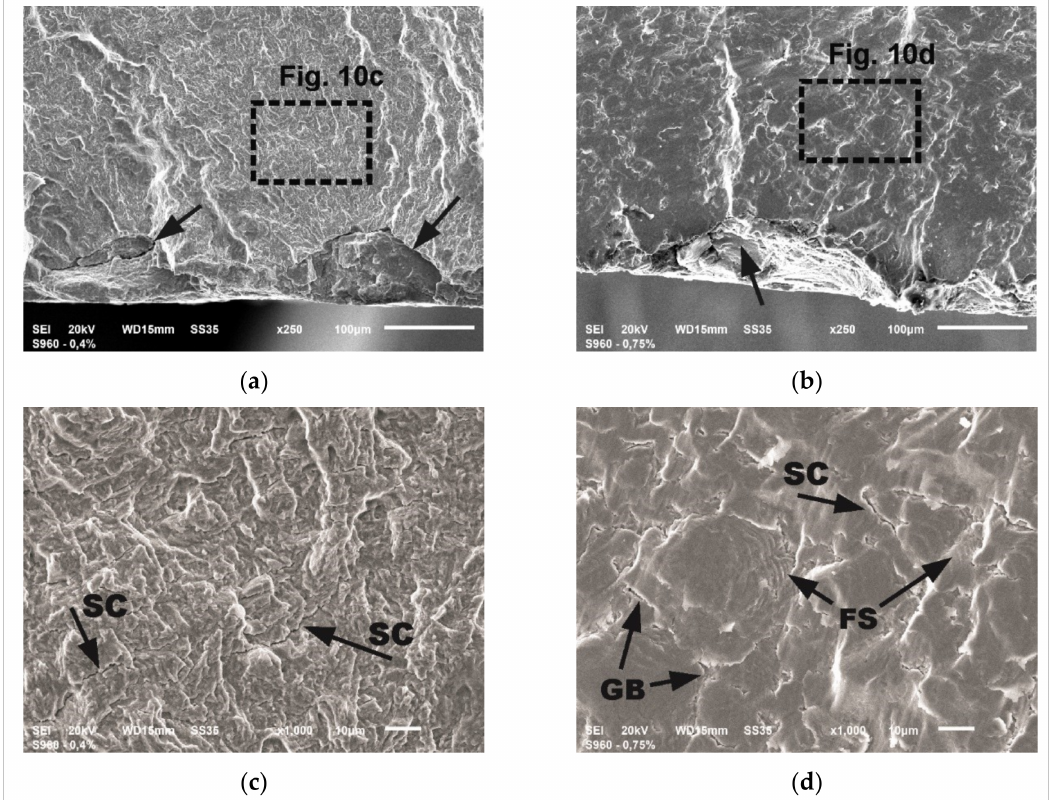
Figure 10. The details of fatigue fractures: ( a ) the origins in sample tested at ε ac = 0.4%; ( b ) the origin in sample tested at ε ac = 0.75%; ( c ) the stage of stable crack growth in sample tested at ε ac = 0.4%; ( d ) the stage of stable crack growth in sample tested at ε ac =